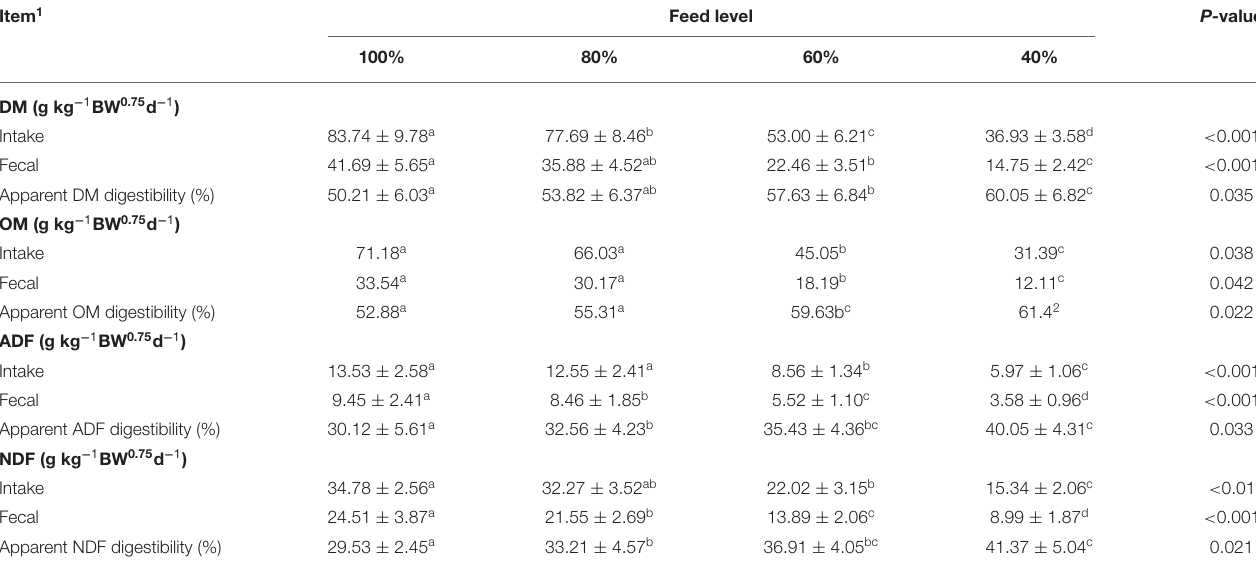
TABLE 5 | Effect of feed intake level on DM, ADF and NDF intake, excretion and apparent digestibility by sika deer. Item